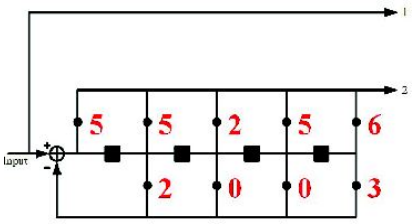
Figure 7. 7-ary, constraint length = 4,